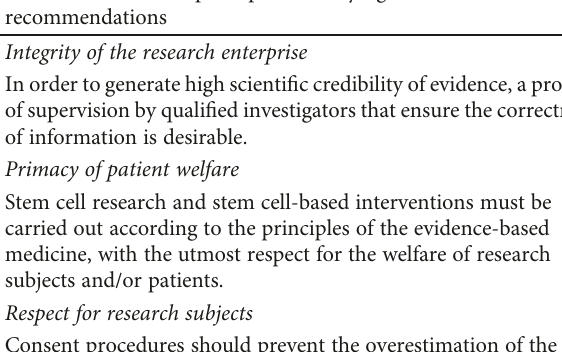
Table 2: Ethical bases of scienti fi c research and translational medicine.